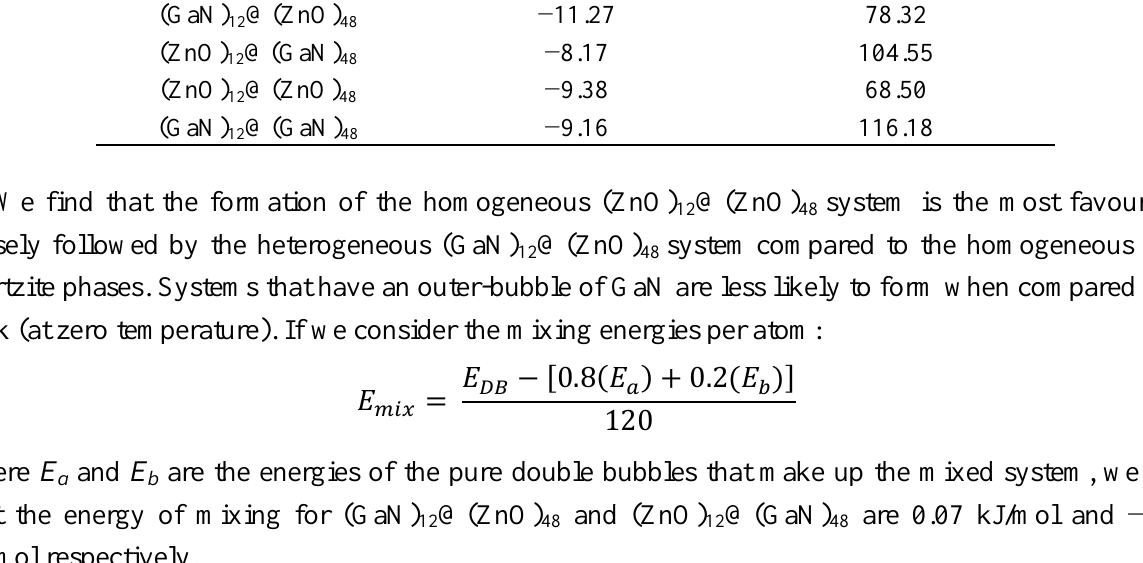
of single-shell cages and enthalpy of formation, Assoc